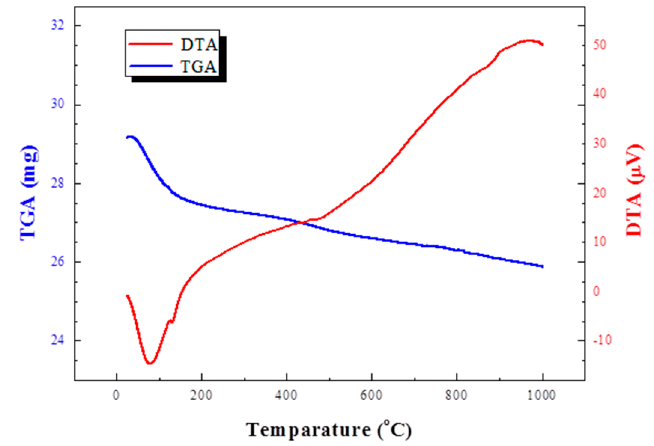
Figure 3. Thermogravimetry-differential thermal Analysis ( TG-DTA) results of acid clay.